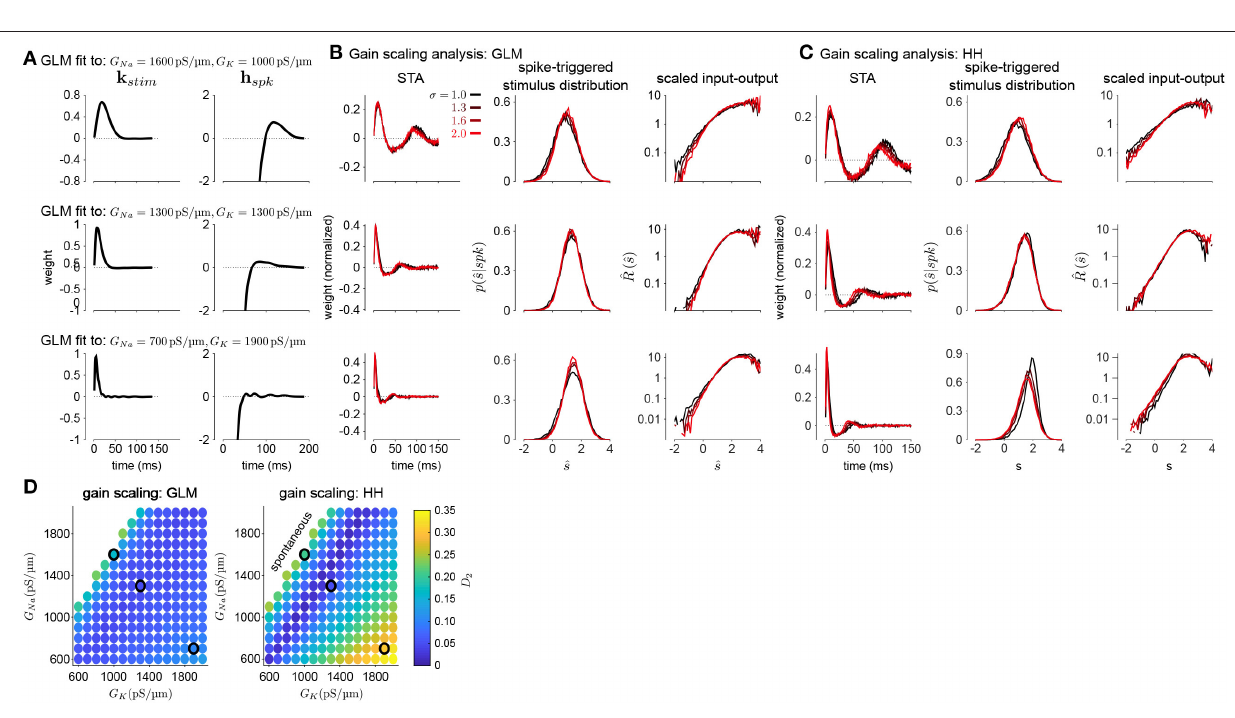
The spike history filter bases were constructed in two